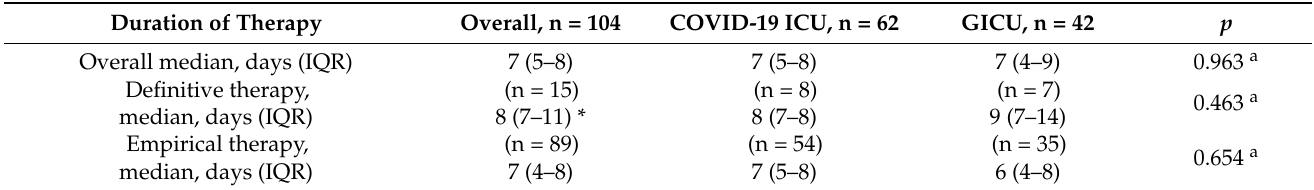
Table 6. Duration of carbapenems